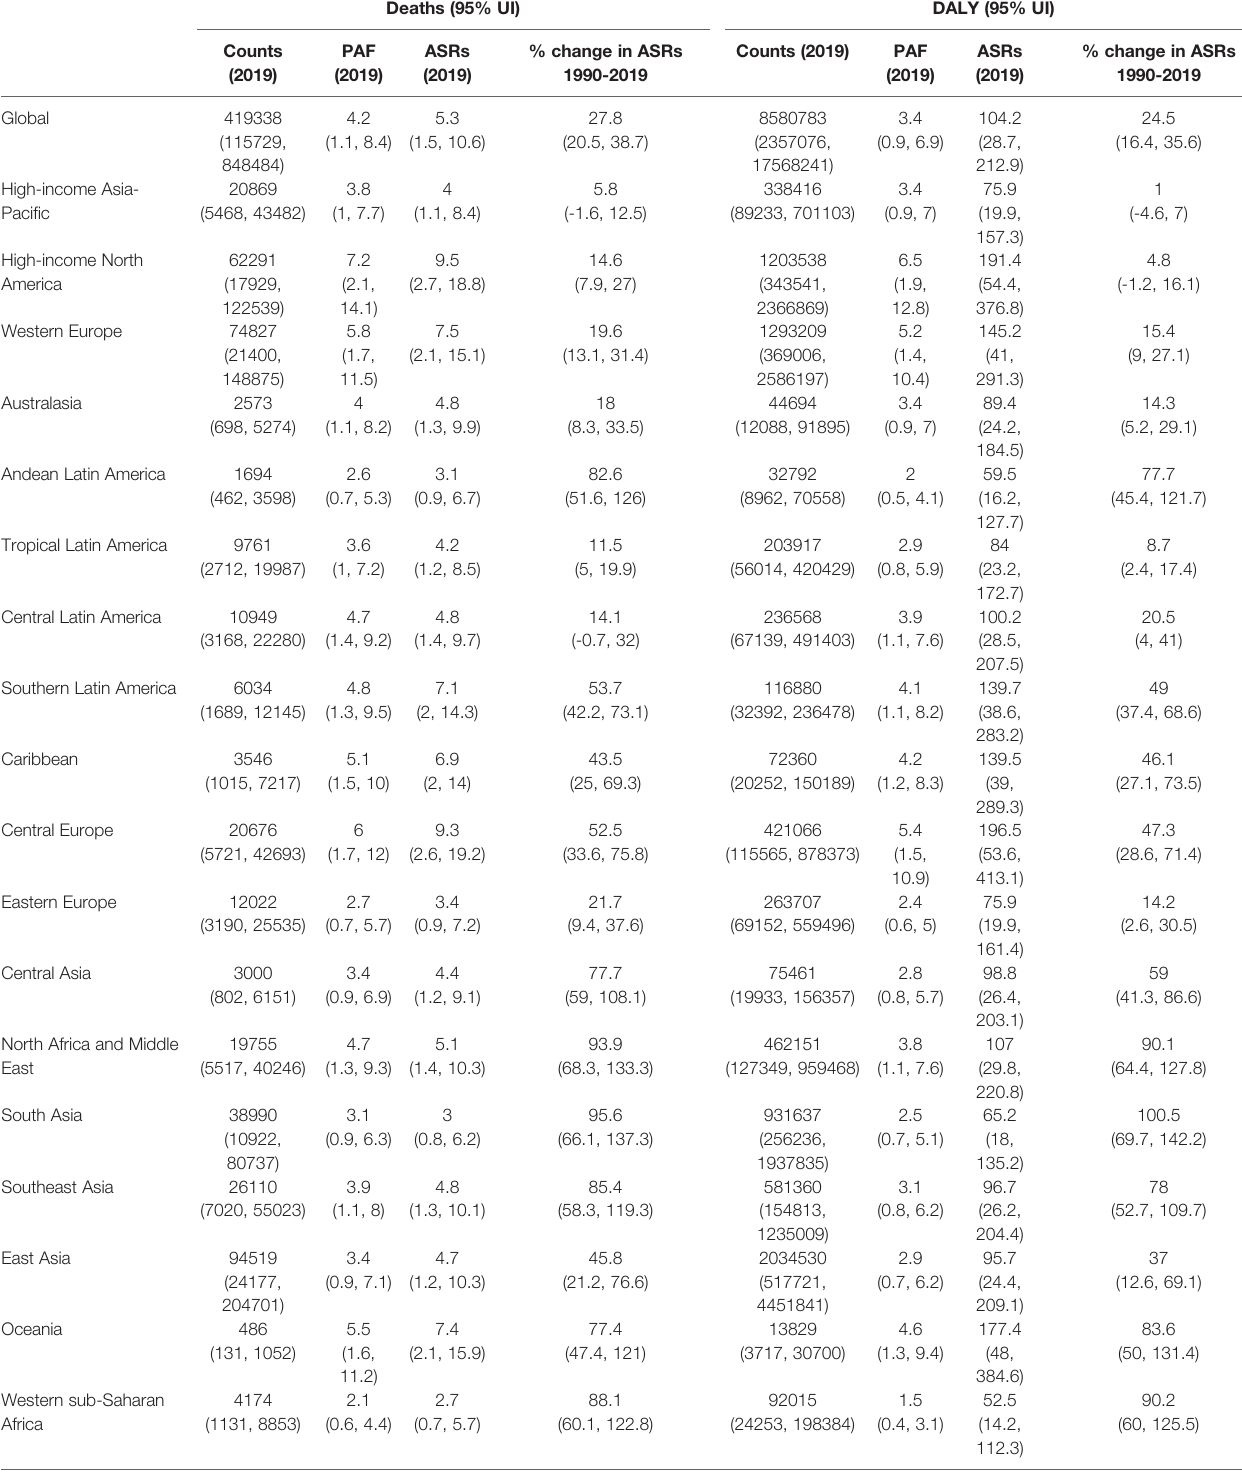
TABLE 1 | Cancer deaths and DALYs attributable to high fasting plasma glucose in 2019, by GBD region (Generated from data available from http://ghdx.healthdata. org/gbd-results-tool)